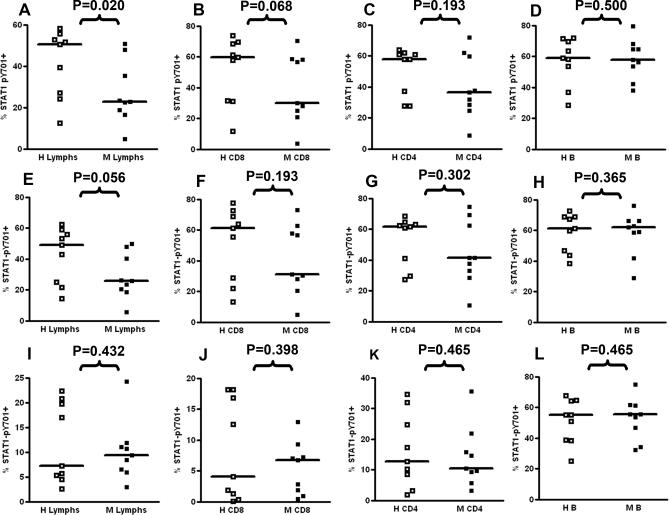
Percentage of STAT1-pY701-Positive Cells in Lymphocytes from Patients with Melanoma and Healthy Controls in Response to IFN StimulationPBMCs from patients with melanoma and healthy controls were stimulated with 1,000 IU/ml IFN-α, IFN-β, or IFN-γ. The percentage of STAT1-pY701-positive cells was measured by Phosflow. p-Values were calculated using the Wilcoxon rank sum test (one-sided). Medians are indicated by the bar in each scatter column. H, healthy; M, melanoma.(A–D) IFN-α-stimulated PBMCs. Lymphocytes (A); CD8 T cells (B); CD4 T cells (C); B cells (D).(E–H) IFN-β-stimulated PBMCs. Lymphocytes (E); CD8 T cells (F); (G) CD4 T cells (G); B cells (H).(I–L) IFN-γ-stimulated PBMCs. Lymphocytes (I); CD8 T cells (J); CD4 T cells (K); B cells (L).